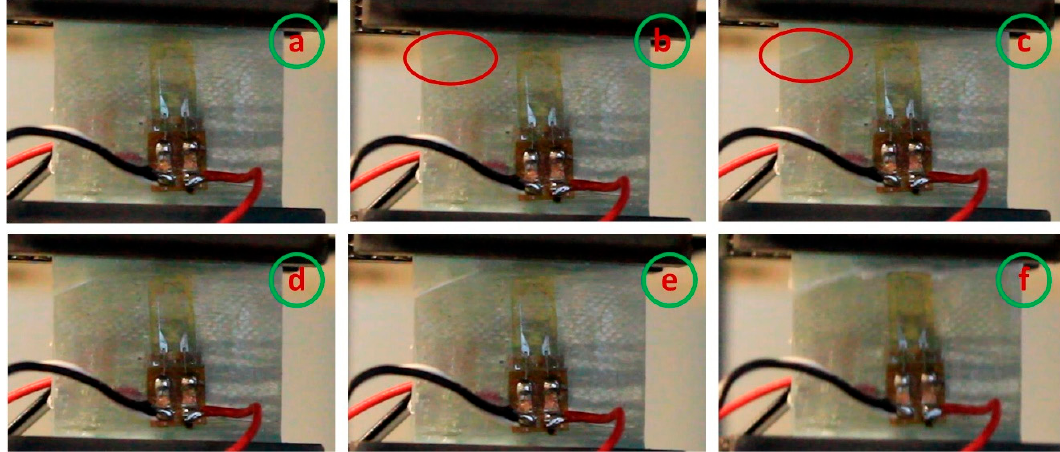
Figure 7. Sequence of crack propagation before complete failure in sample A1: (a) at the start of the test, (b) crack initiation (region within the red color oval), (c) crack propagation towards the free edge, (d) & (e) widening of the crack, and (f) failure.